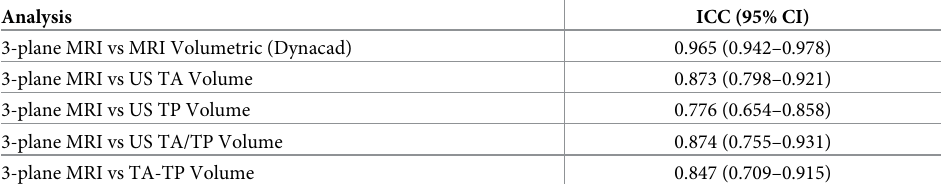
Table 3. Intraclass correlation coefficient (ICC) agreement between MRI-derived and US-derived prostate volumes.